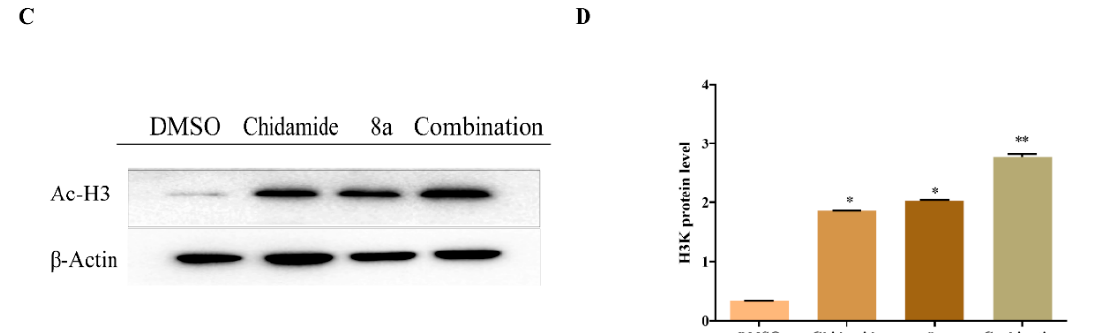
Figure 2. ( A ) Cell viability through use of an MTT assay. U937 cells were treated with different concentrations of 8a (0.75, 1, 2.5, 5, 10, and 25 µ M) for different amounts of time (24, 48, and 72 h). ( B ) Cell co-localization. U937 cells were cultured for 48 h with 2 µ M of 8a , and its emission peak is 476 nm. The cell nuclei were stained with 4 (cid:48) ,6-diamidino-2-phenylindole (DAPI), and the membranes were stained with 1,1 (cid:48) -dioctadecyl-3,3,3 (cid:48) ,3 (cid:48) -tetramethylindocarbocyanine perchlorate (DIL). Samples were observed under a 20x aperture through a fluorescent microscope (Axio Observer 5 with ApoTome). ( C , D ) Ac-H3 Western blots. U937 cells were treated with 8a (2 µ M), chidamide (0.5 µ M), or their combination for 48 h, and Western blots analysis was used to evaluate the levels of Ac-H3; 0.1% dimethyl sulfoxide (DMSO) was used as a negative control. (* p < 0.05, ** p <